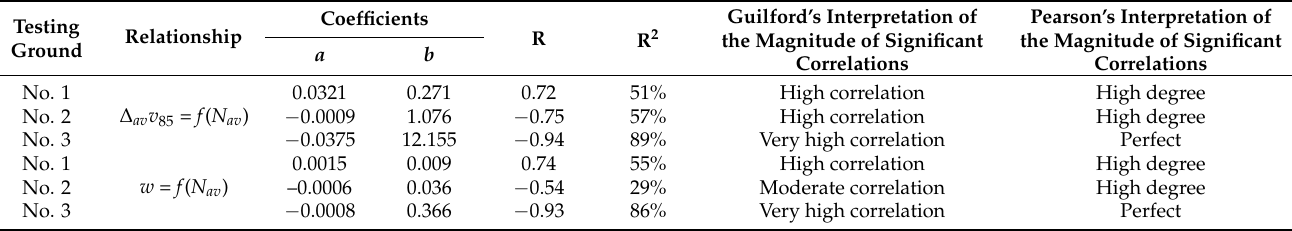
Figure 18. Summary of 85th percentile free-flow speed changes depending on hourly traffic (testing ground No. 3). Source: own work of the author. Table 2. Regression analysis